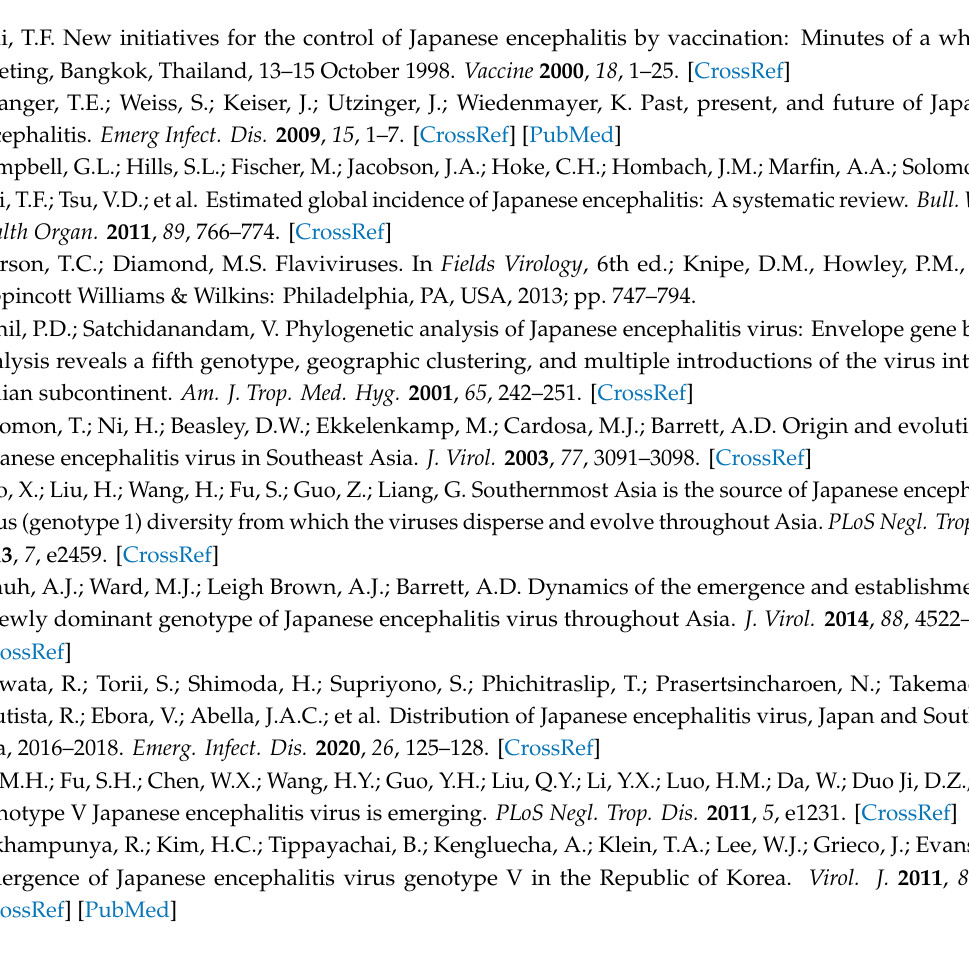
Figure S3: Plaque morphology of NS1-3 Muar viruses passaged in Neuro-2a